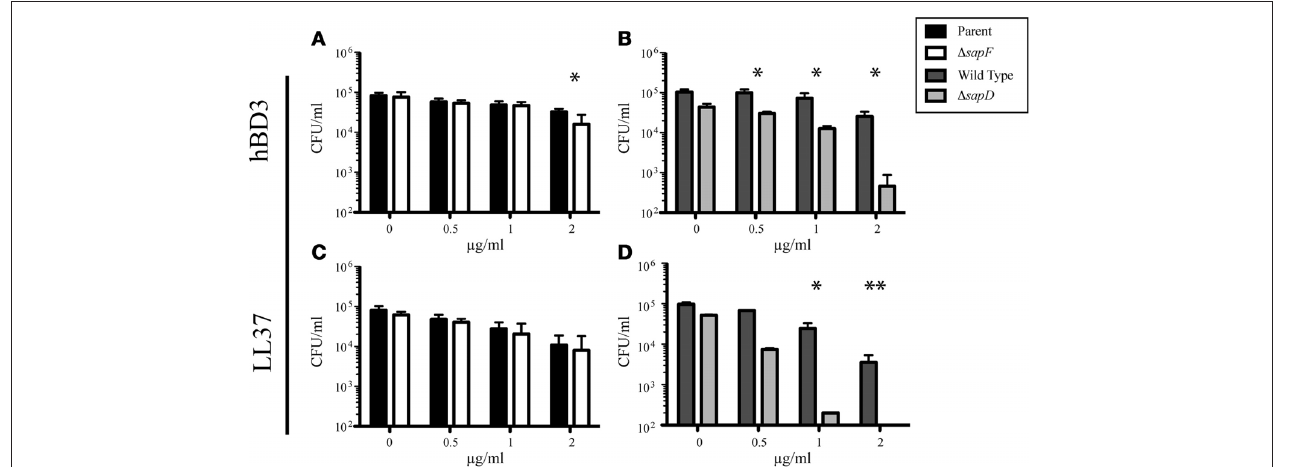
FIGURE 1 | The SapF ATPase is dispensable for resistance to the AMPs hBD-3 and LL-37. The parent strain and the SapF ATPase-deficient strain ( A and C ) or the Wild Type and SapD-ATPase deficient strain ( B and D ) were incubated with increasing concentrations of hBD-3 ( A and B ) or LL-37 ( C and D ) for 1h and then plated on chocolate agar for enumeration of viable